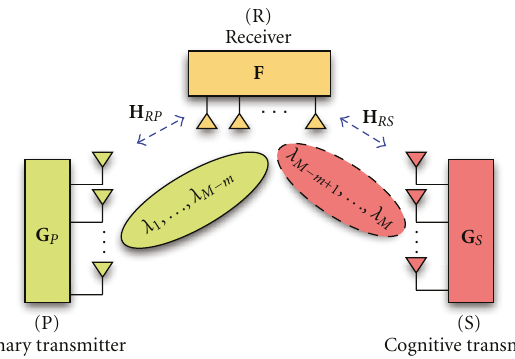
Figure 1: Cognitive transmission in an M × M MIMO channel via SVD and space